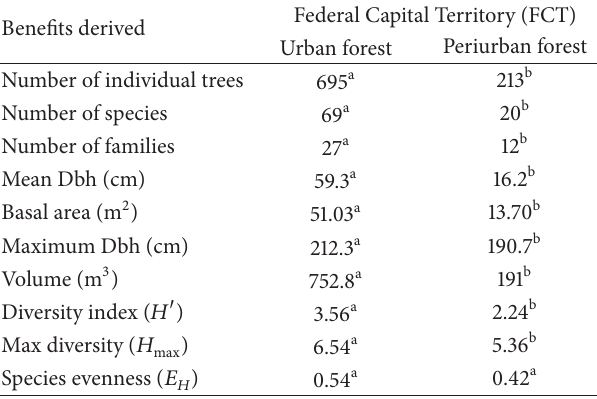
Table 1: Summary result of biodiversity indices and growth param- eters for tree species in urban and periurban areas of